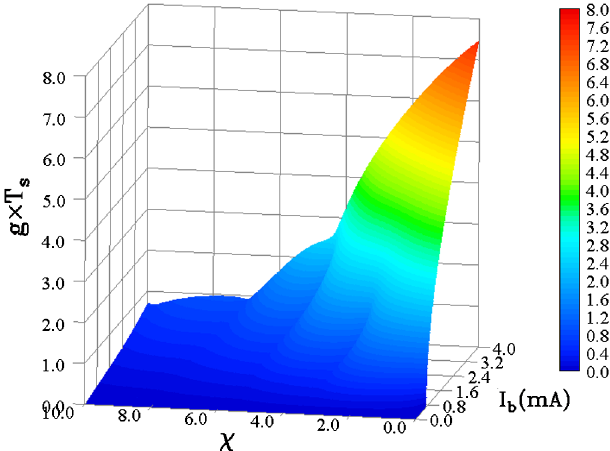
FIG. 21. The impedances of the two models. The black line is ¼ 2 cm), and the red line is for the trapezoidal wake model ( σ z for the LEP broadband resonator impedance model, respectively. The real and the imaginary parts of the impedance are denoted by the solid and the dashed lines,